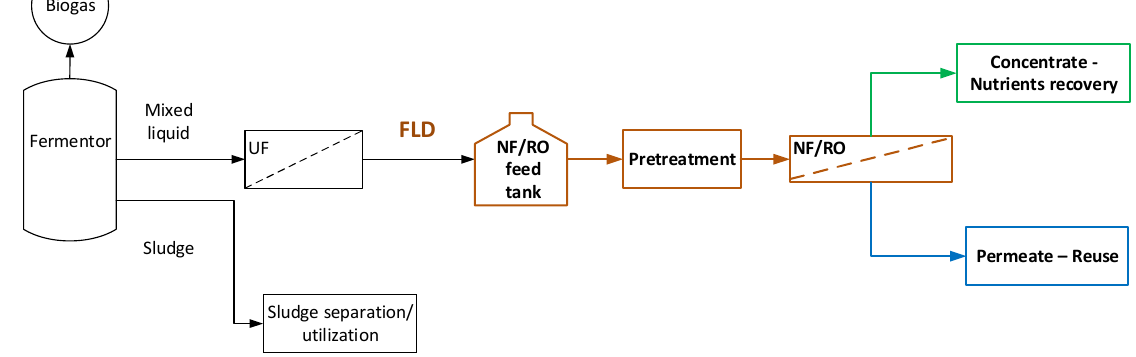
Figure 1. Block flow diagram of membrane-based process for complete valorization of anaerobic fermentation liquid digestate (FLD).